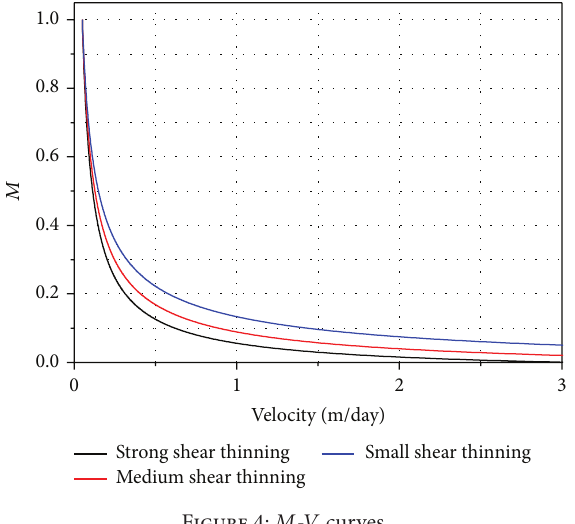
Figure 4: 𝑀 - 𝑉 curves.